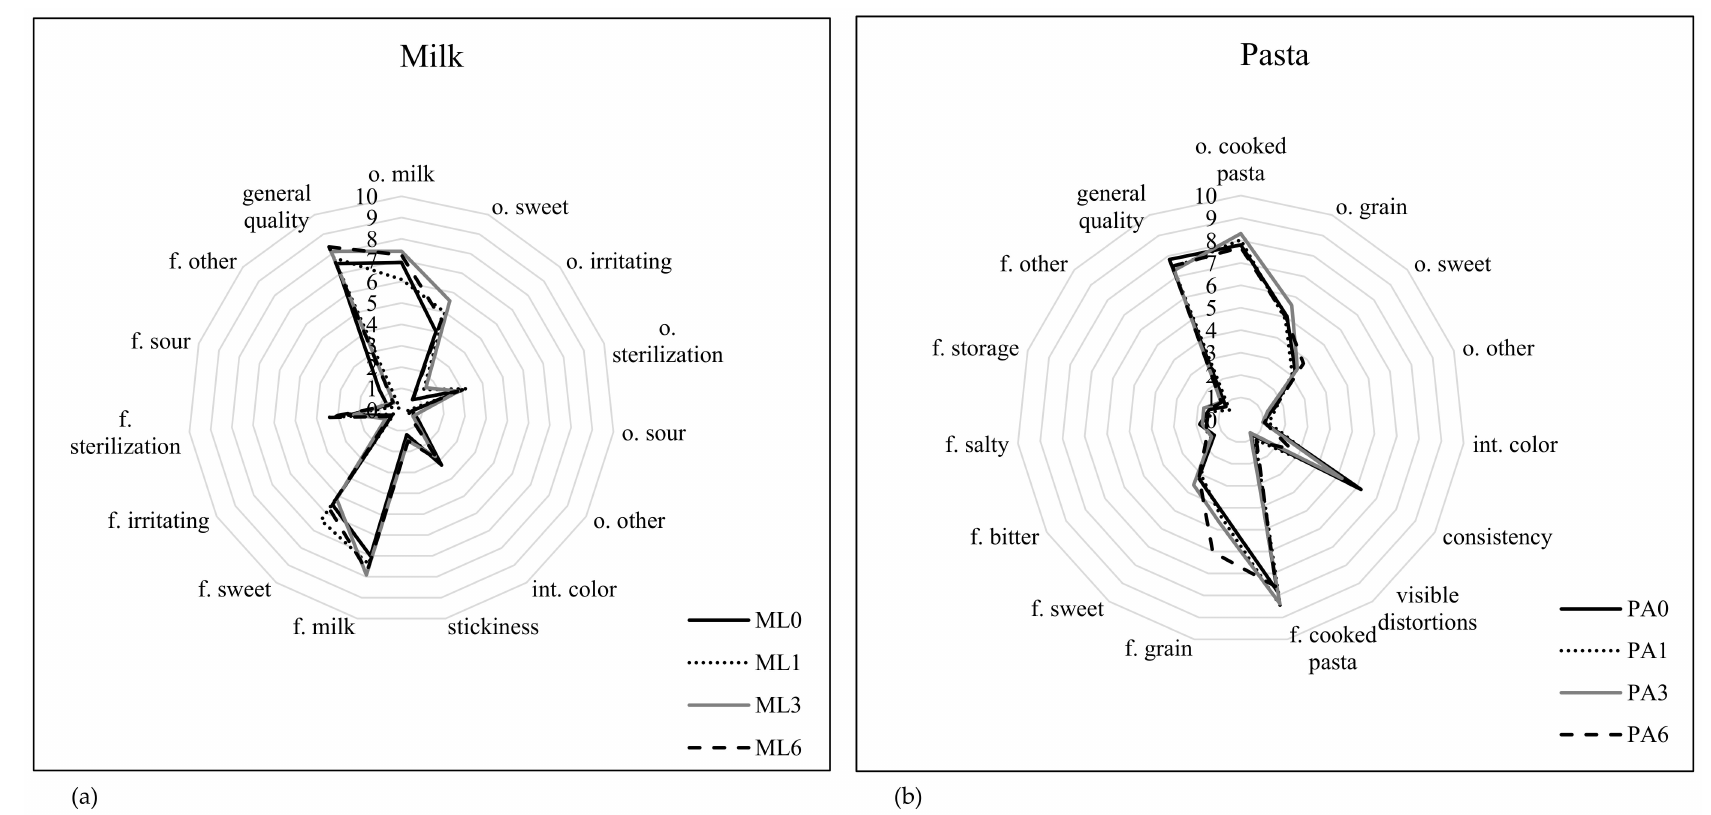
Figure 2. Sensory evaluation of the milk ( a ) and pasta ( b ).Explanatory notes: o–odour; int–intensity; f–flavour; ML–milk, PA–pasta; ML0 and PA0–time 0 (“best before” date); ML1 and PA1–1 month after the “best before” date; ML3 and PA3–3 months after the “best before” date; ML6 and PA6–6 months after the “best before”